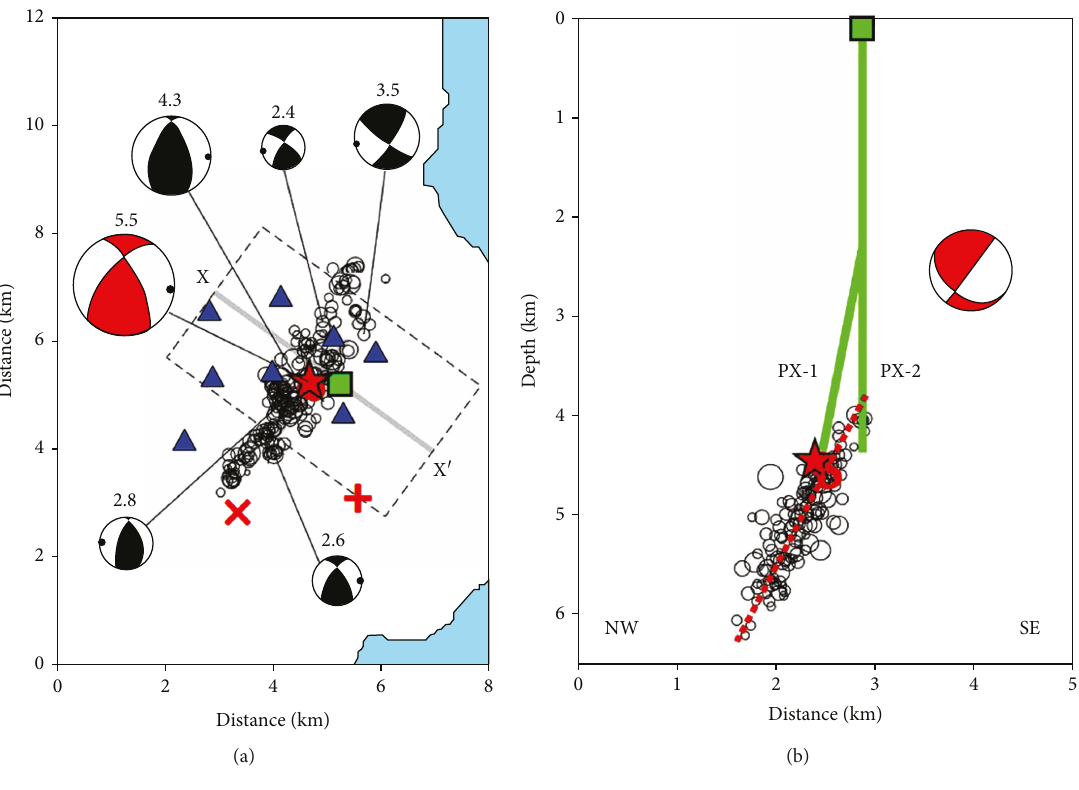
, are drawn as standard lower (or W